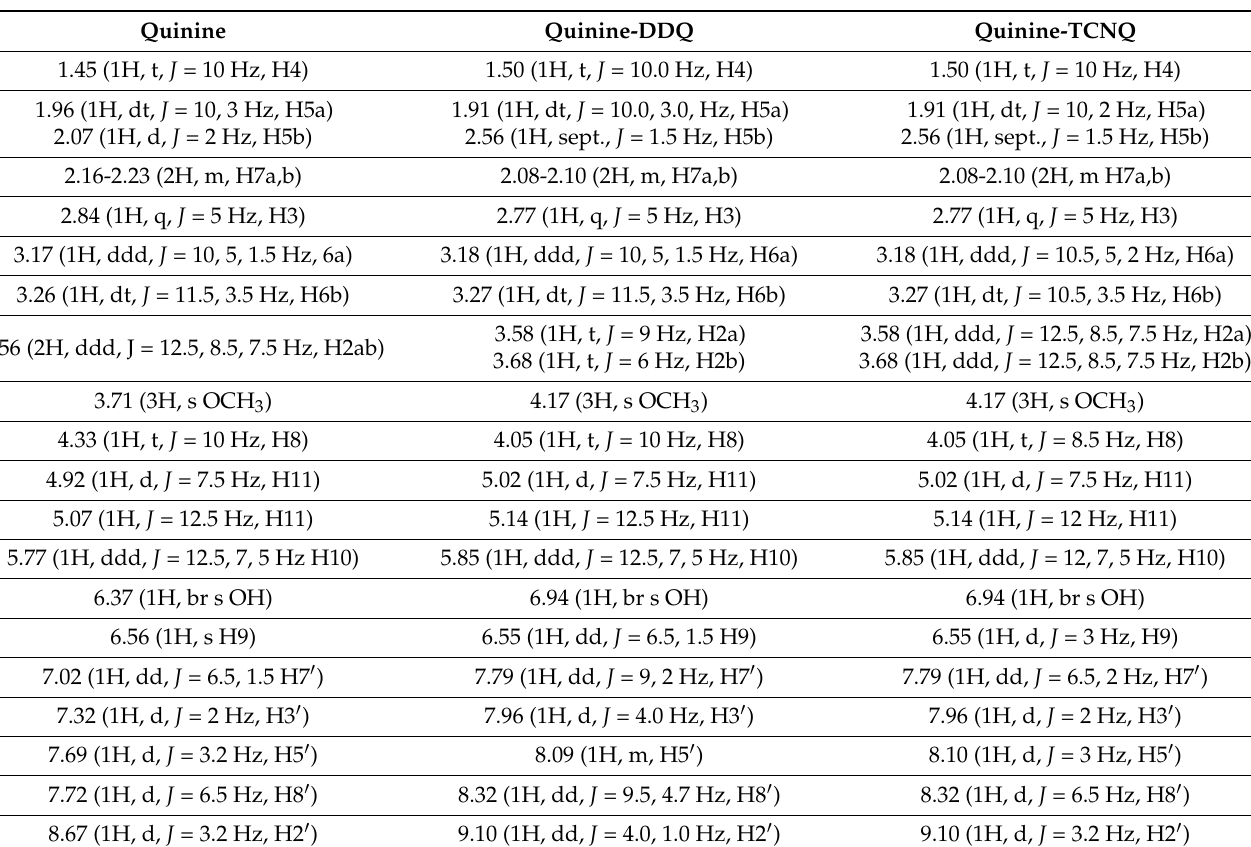
Table 3. 1 H NMR chemical shifts in ppm for quinine and quinine-DDQ, and quinine-TCNQ charge- transfer